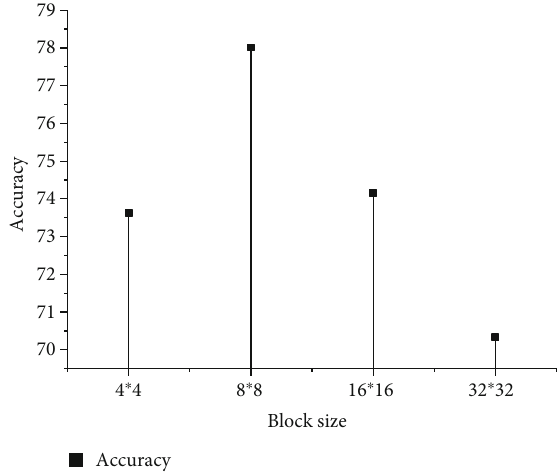
Figure 4: Accuracy under di ff erent block